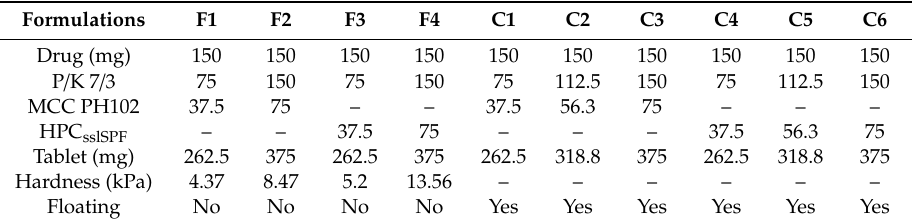
Figure 3. Dissolution profiles of nilotinib in simulated gastric fluid (SGF) from formulations F1–F3 ( A ) and C1–C6 ( B ). Table 6. Composition of formulations F1–F4 and